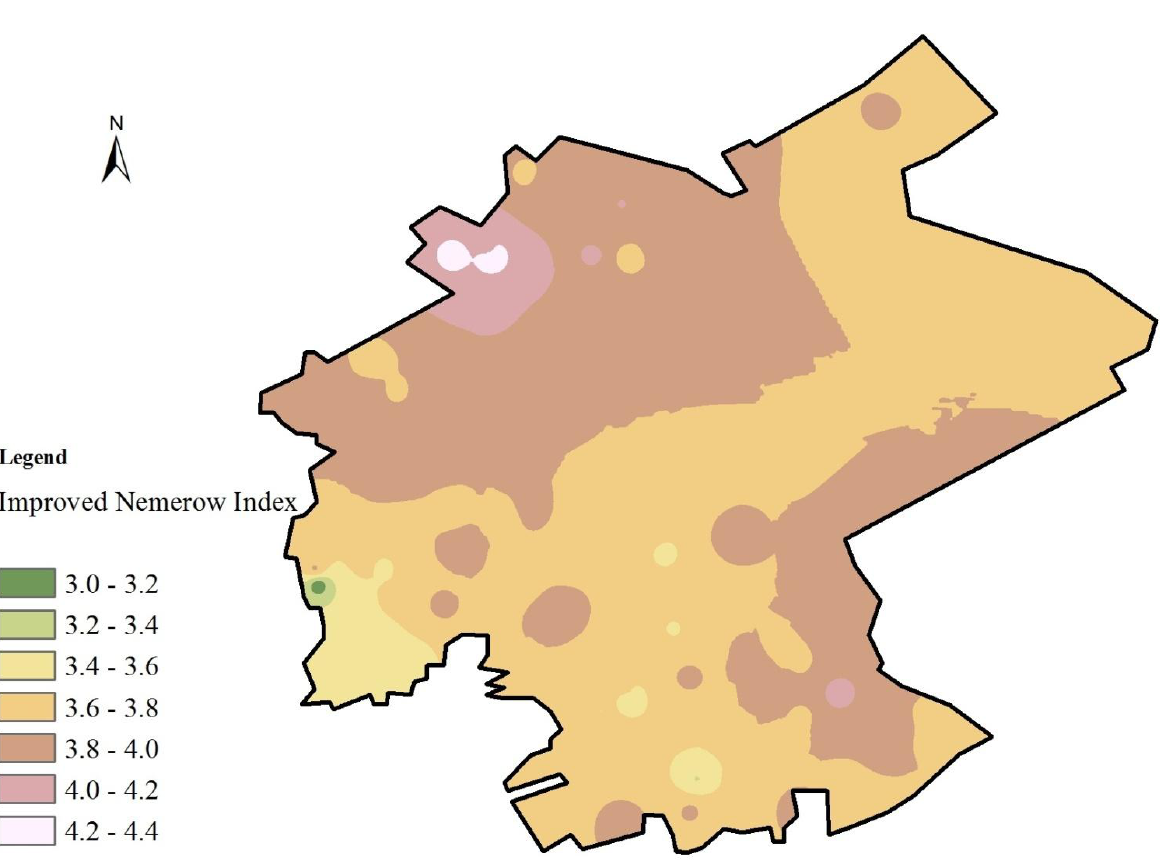
Figure 6. Spatial distribution map of I